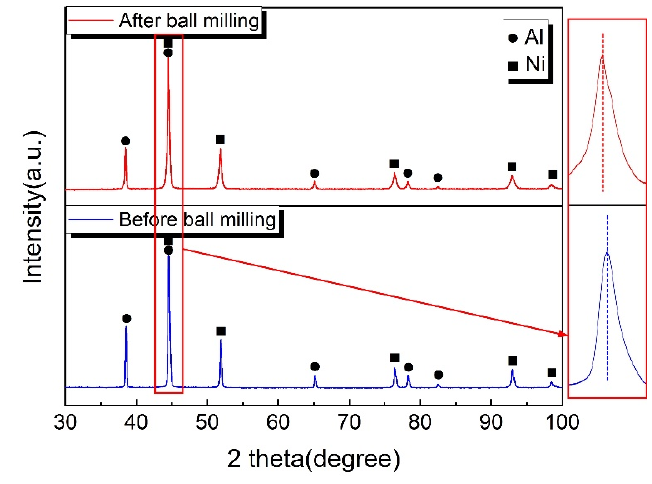
Figure 5. XRD results of the Al/Ni energetic composites.